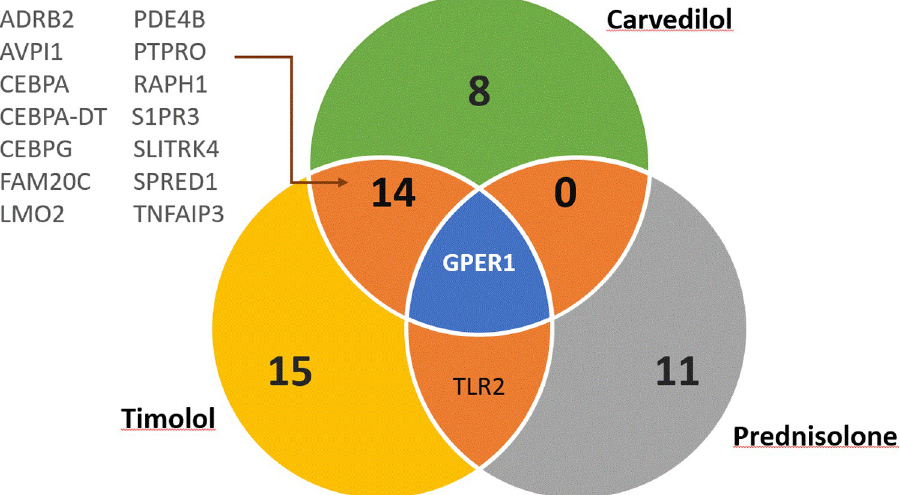
Fig 4. Genes overexpressed by more than one substance. Analysis shows high overlap between timolol and carvedilol.